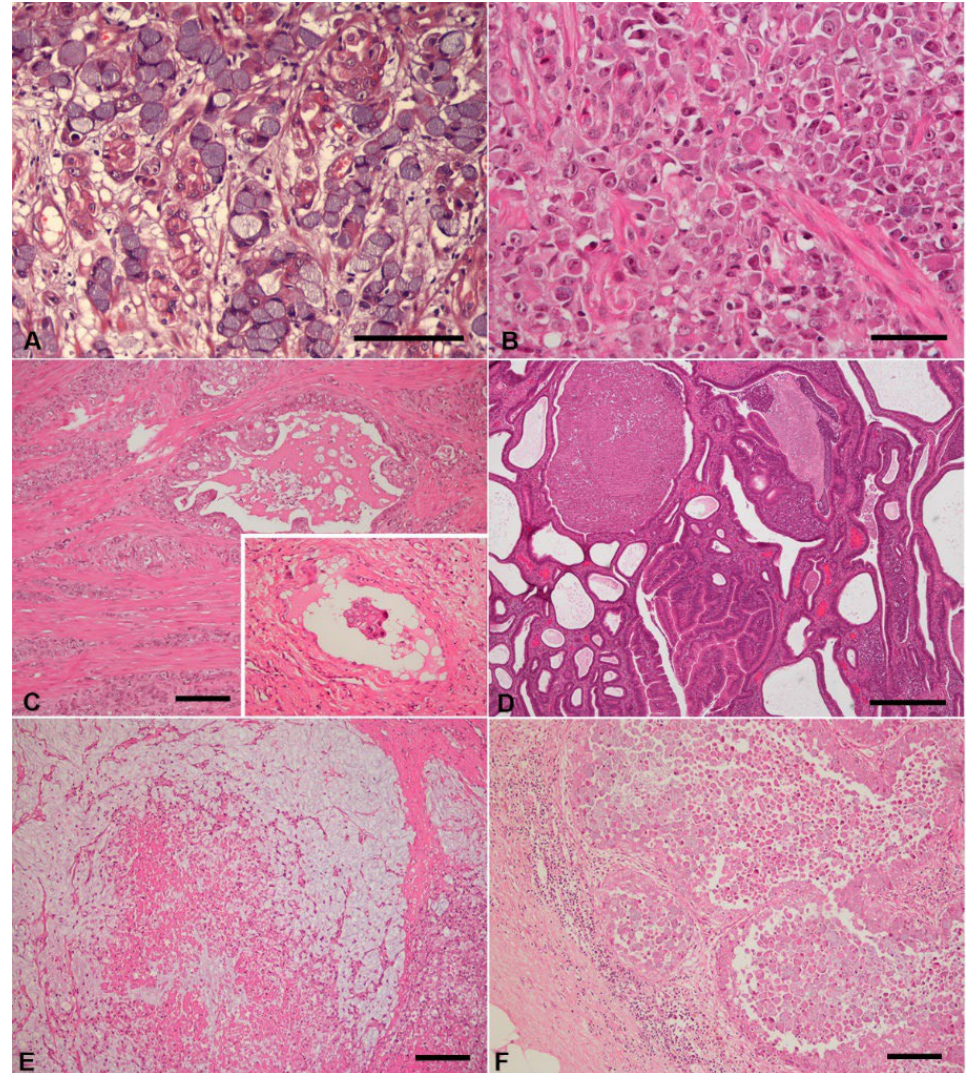
Figure 1. Histopathological features of gastric carcinomas and lymph node metastases. ( A ) Signet ring cell carcinoma (WHO) and diffuse type carcinoma (Lauren) composed by signet ring tumor cells (bar = 100 μm). ( B ) poorly cohesive carcinoma (WHO) and diffuse-type carcinoma (Lauren) constitute of poorly cohesive neoplastic cells (bar = 50 μm). ( C ) intestinal component of a mixed carcinoma (WHO) and indeterminate type carcinoma (Lauren) composed of a mixture of neoplastic epithelial cells organized in tubules of various sizes and nests, scattered throughout the tunica muscularis (bar = 100 μm). Inset shows neoplastic emboli (200×). ( D ) Tubular carcinoma (WHO) and intestinal type carcinoma (Lauren) consisting of numerous dilated and irregular tubular structures, occasionally with intraluminal small papillae and mucus (bar = 500 μm). ( E ) Mucinous carcinoma (WHO) and diffuse type carcinoma (Lauren) with scattered signet ring cells embedded in extracel- lular mucin lakes (bar = 100 μm). ( F ) Lymph node metastasis of a poorly cohesive carcinoma (WHO) and diffuse type carcinoma (Lauren), with large clusters of neoplastic epithelial cells. Note a few aggregates of lymphoid cells at the periphery (bar = 100 μm).